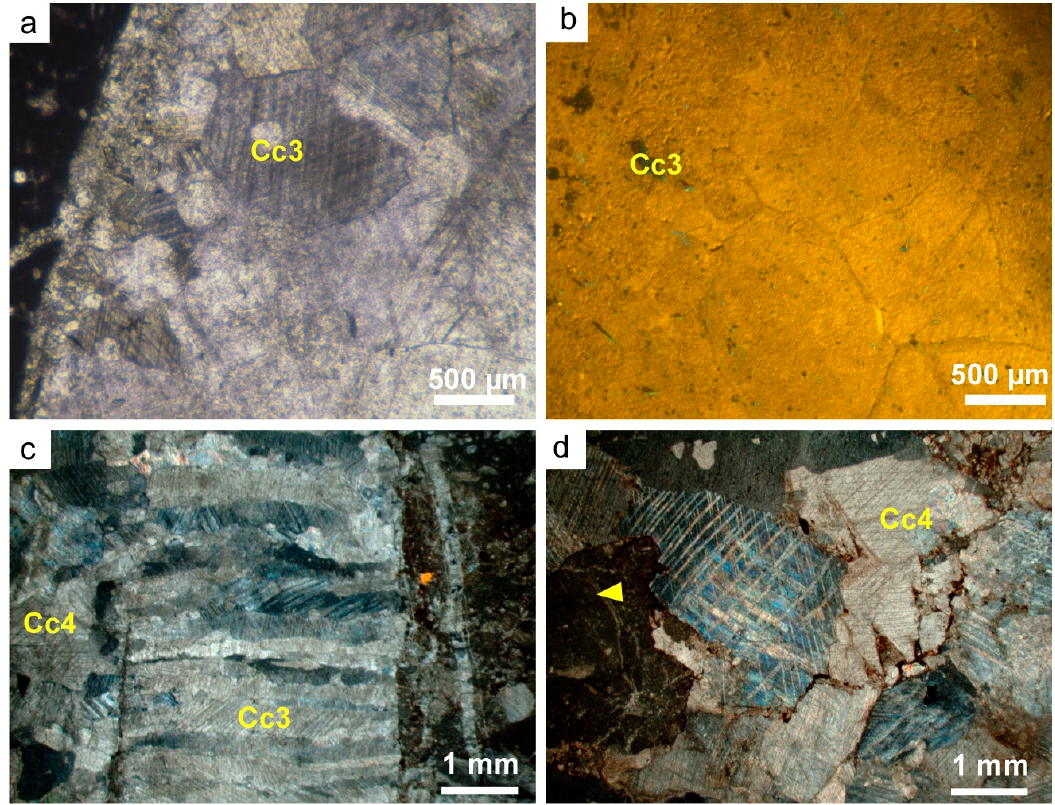
Figure 10. ( a , b ) Calcite cement Cc3 under polarized optical microscope and CL, respectively (sample CN20). ( c ) Crosscutting relationship between calcite cements Cc3 and Cc4 (sample CN26). ( d ) Calcite cement Cc4 with tabular thick twin planes (sample CN3). The yellow arrow points a carbonate clast